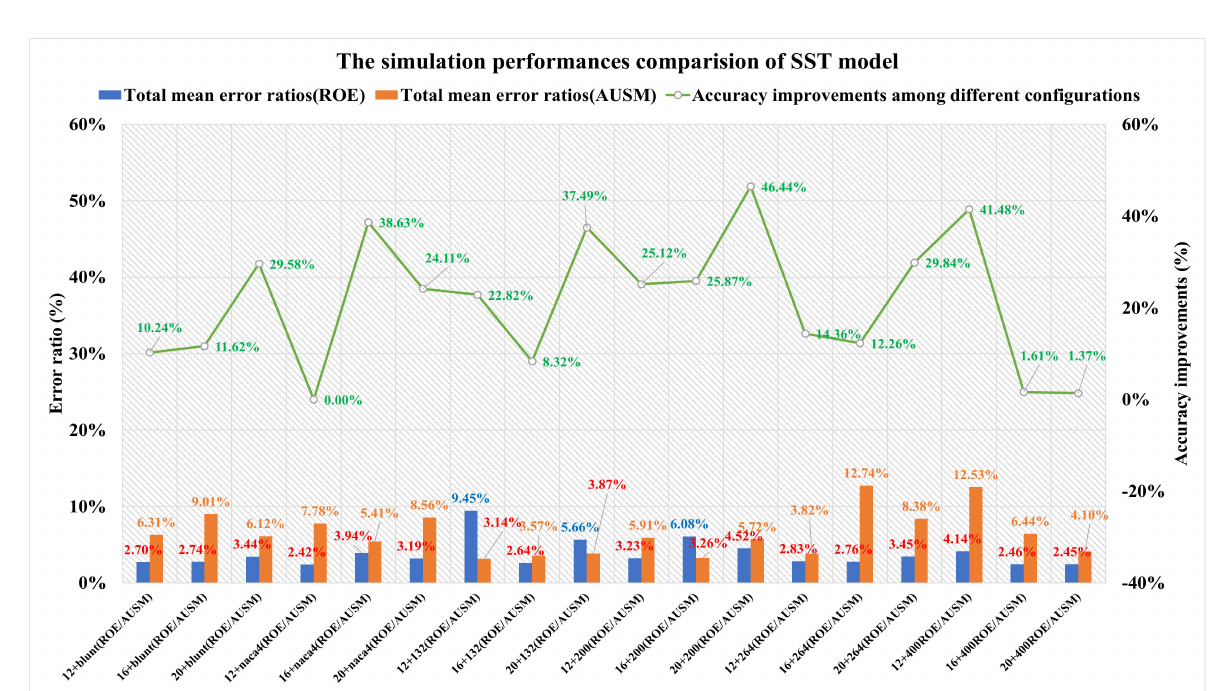
Figure 30. Comparison of the simulation performances of SST turbulence model under different simulation